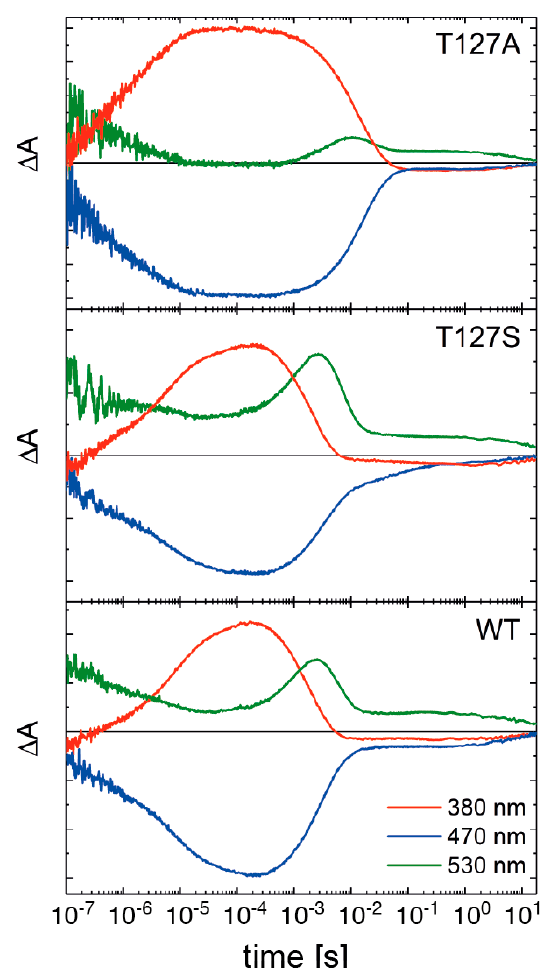
Figure 7. Kinetics in the UV/Vis range recorded after pulsed laser excitation (450 nm). Traces at 380 nm (red lines), 470 nm (blue), and 530 nm (green) are shown for each variant. While the T127A variant (top panel) showed a prolonged lifetime of the P 2380 state and reduced P 3530 formation, the T127S variant (middle panel) had very similar kinetics to the WT (bottom panel).